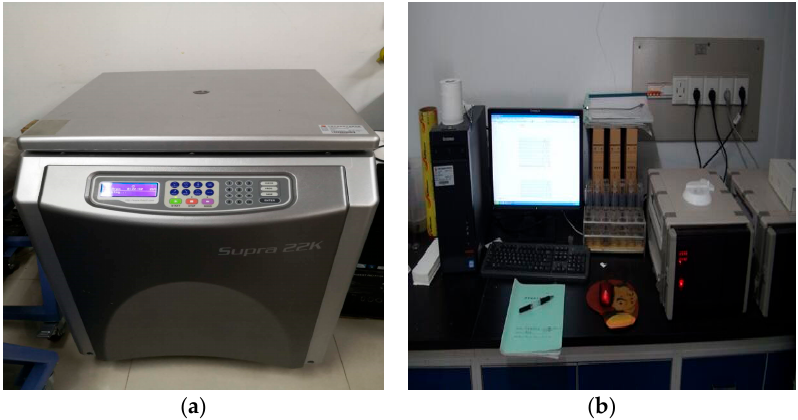
Figure 1. Experimental apparatus used for measuring movable water saturation: ( a ) High speed centrifuge; ( b ) Nuclear magnetic resonance (NMR) detector.